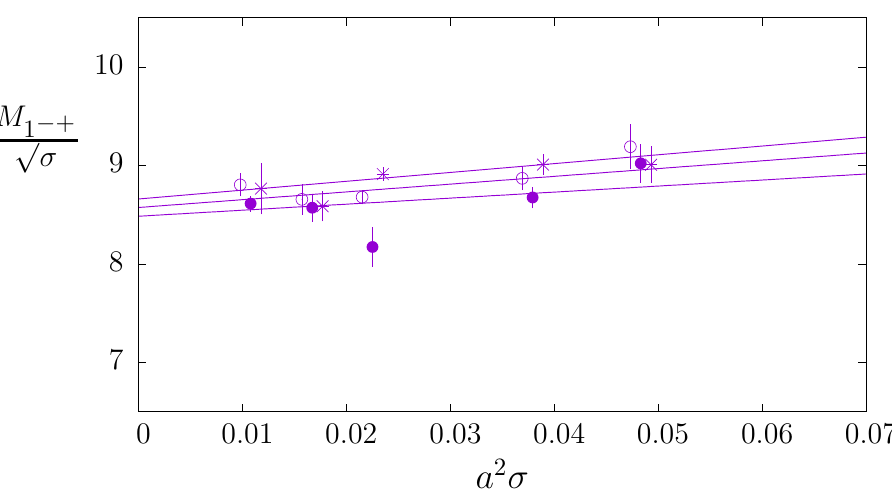
Figure 18 . Continuum extrapolation of the masses of the lightest three J PC = 1 − + glueballs which appear to be (nearly) degenerate. They correspond to the lightest three T 1 − + states, each of which is triply degenerate (corresponding to the three components of each of these three J = 1